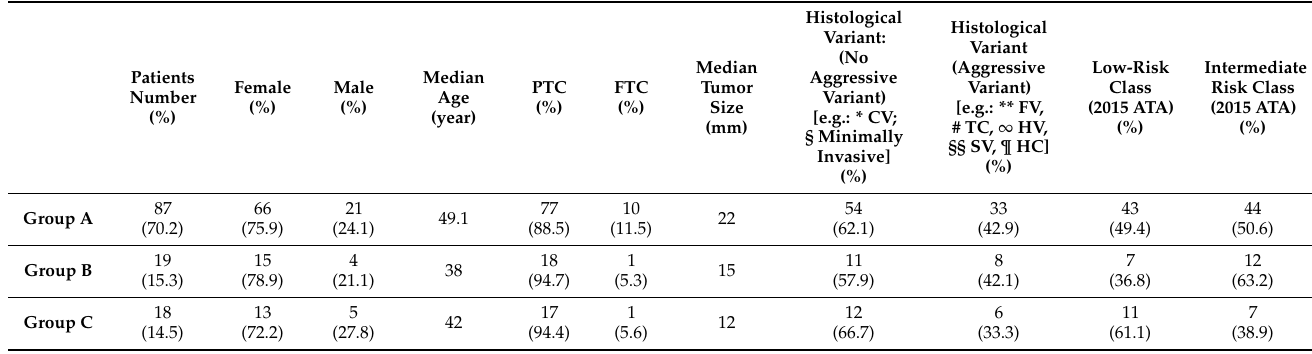
Table 5. Comparison of clinical characteristics of the patients included in different